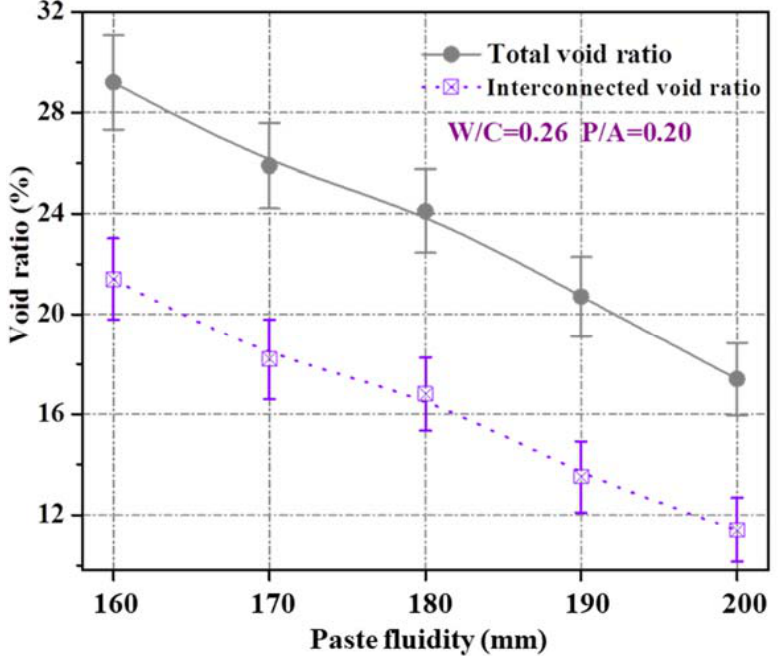
Figure 1. Impact of paste fluidity on void ratio of porous mortar.